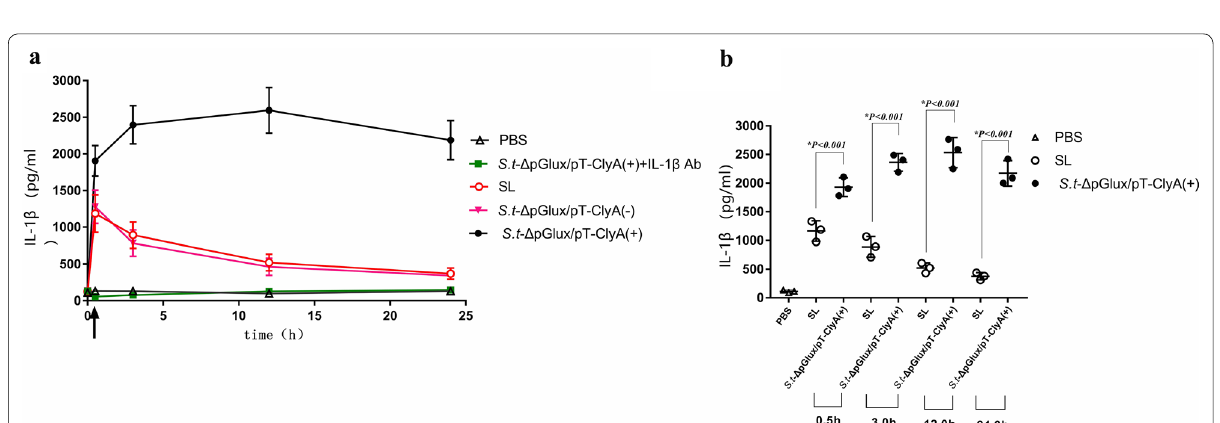
Fig. 5 Serum IL-1β levels in different groups at different time points. a Serum IL-1β levels were measured by ELISA. Results showed that serum IL-1β levels were significantly higher in mice treated with engineered secreting-lux/pT-ClyA salmonella compared to other groups. b Serum IL-1β levels in PBS, SL, S.t -ΔpG lux/pT-ClyA( + ) at indicated